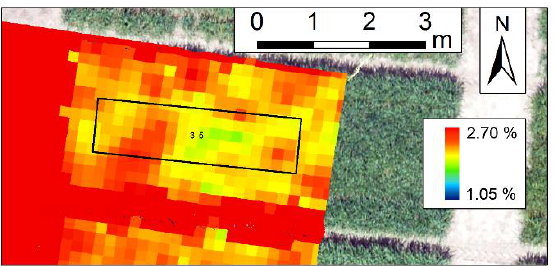
Figure 3 Image cube 2 (IC2) with the reflectance at 670 nm as an overlay on a RGB image.